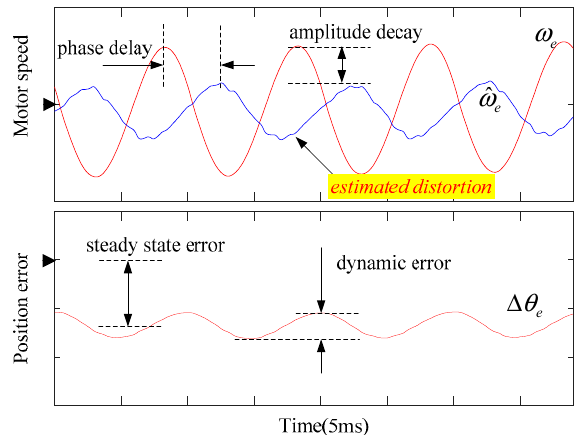
Figure 3. Simulation results of the SMO with small DC-link capacitor.